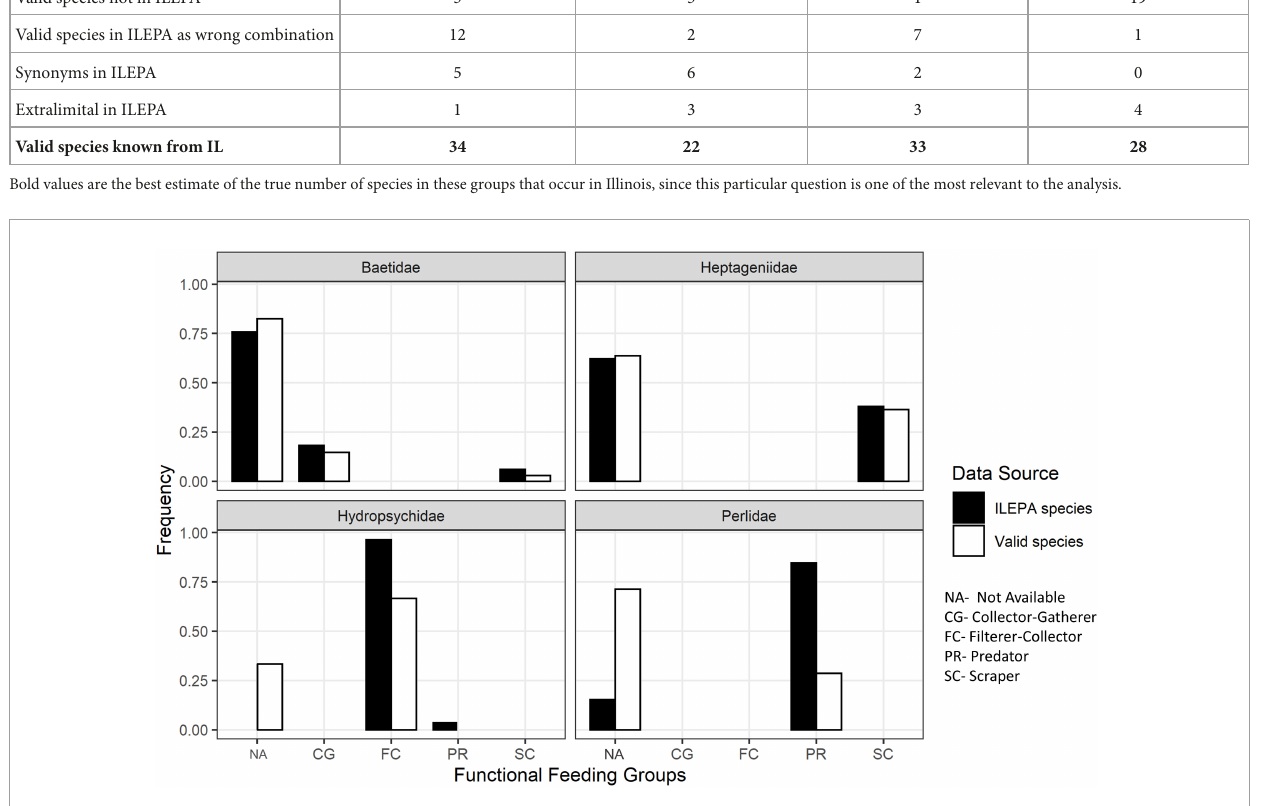
FIGURE1 The frequency of functional feeding groups among the species in the Illinois Environmental Protection Agency [ILEPA] (2011a,b) benthic monitoring database, and the frequency among a list of valid species known to occur in Illinois compiled from museum specimens and literature